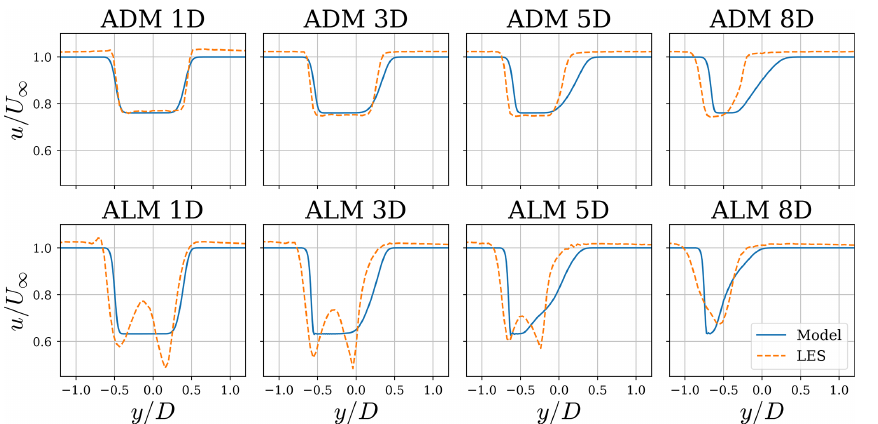
Figure 4. Comparison of axial velocity along a horizontal line between a large-eddy simulation using an actuator disk model (ADM) (a) and actuator line model (ALM) (b) under uniform inflow from Howland et al. (2016) and the proposed model.